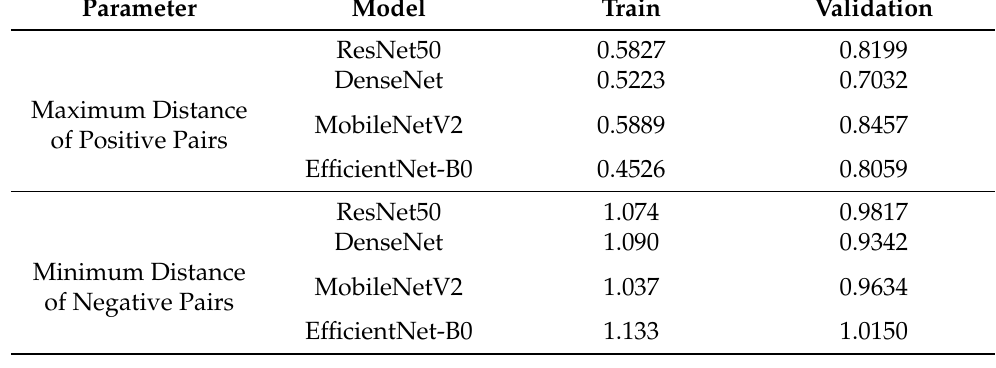
Table 3. Maximum distance of positive pairs and minimum distance of negative pairs of all models.